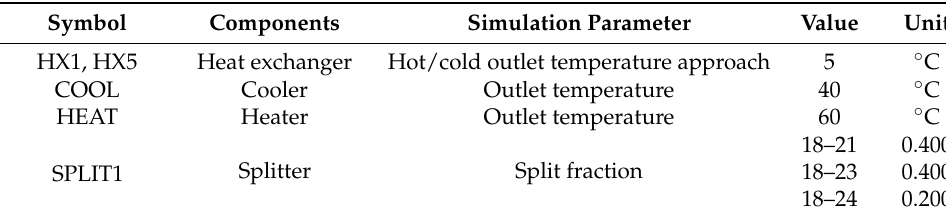
Figure 1. Schematic of the process model for the wastewater heat recovery system. Abbreviations: COMP, compressor; CONDS, condenser; EVAP, evaporator; EXP, expansion valve; HX, heat exchanger; HEAT, (heater); COOL, (cooler); MIX, mixer; SPLIT, splitter. Table 2. Specifications of the heat exchanger, cooler, heater, and splitter.